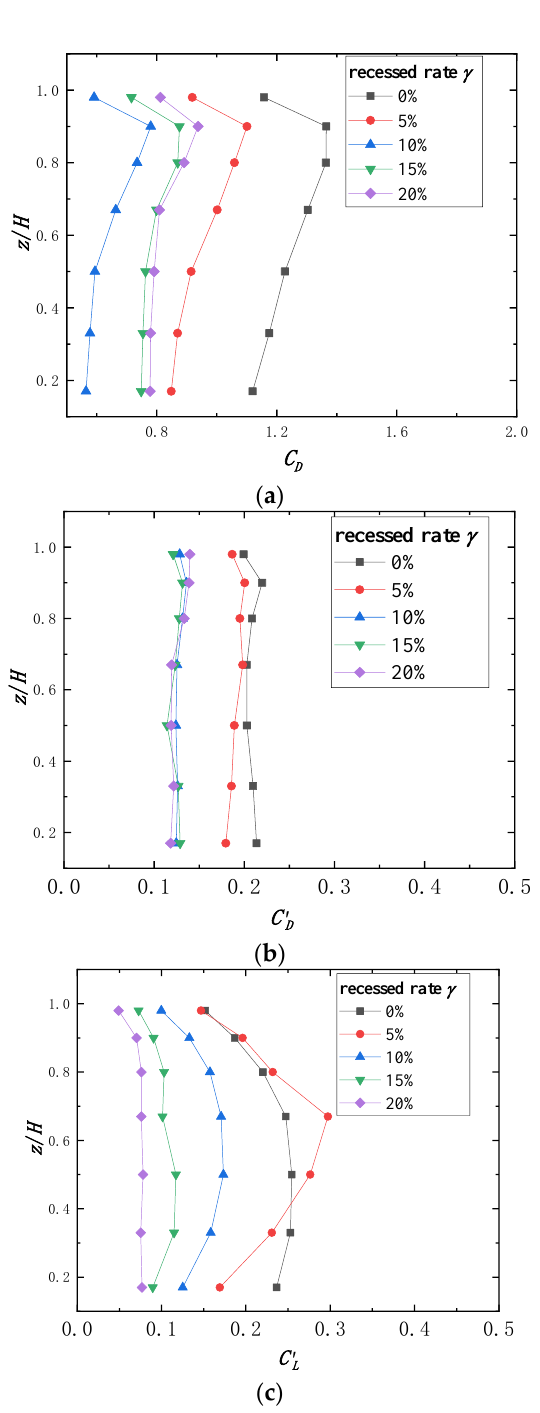
Figure 9. The local wind force coefficients. ( a ) Mean drag force coefficients along height. ( b ) RMS drag force coefficients along height. ( c ) RMS lift force coefficients along